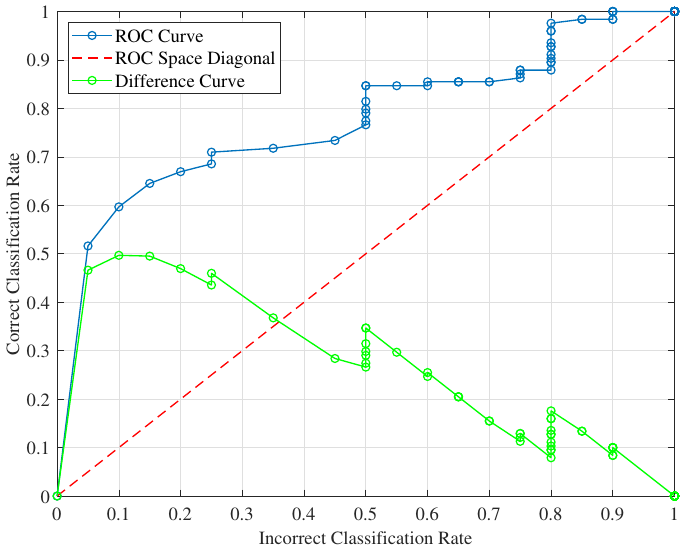
Figure 5. Resulting ROC Curve for the TGB30 classification from the Densenet121 architecture trained on